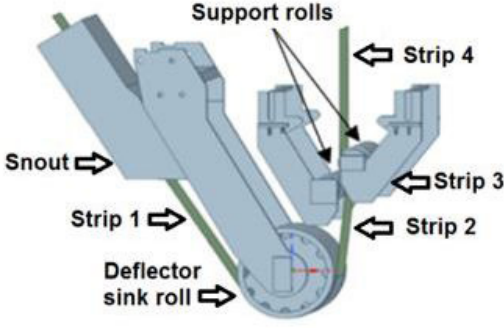
Figure 3. Definition of regions inside the zinc